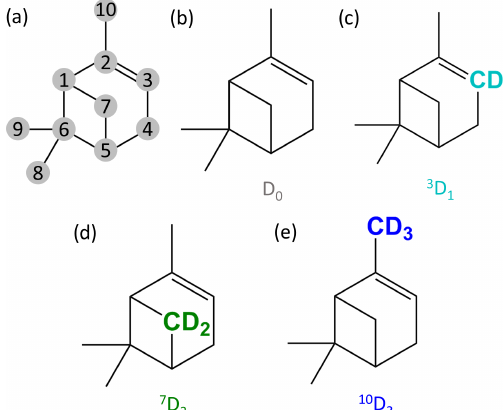
Figure 1. α -pinene with numbered carbons following IUPAC num- bering (a) and the molecular structures of the selectively deuterated precursors used in this study (b–e) . The precursors are named based on the number of the carbon that is deuterated and the number of deuterium atoms added to the molecule. The carbons with the deu- terium atoms are highlighted with colours specific to the precursors. (b) Normal α -pinene is D 0 , (c) α -pinene with one deuterium atom is 3 D 1 (cyan), (d) α -pinene with two deuterium atoms is and (e) α -pinene with three deuterium atoms is 10 D 3